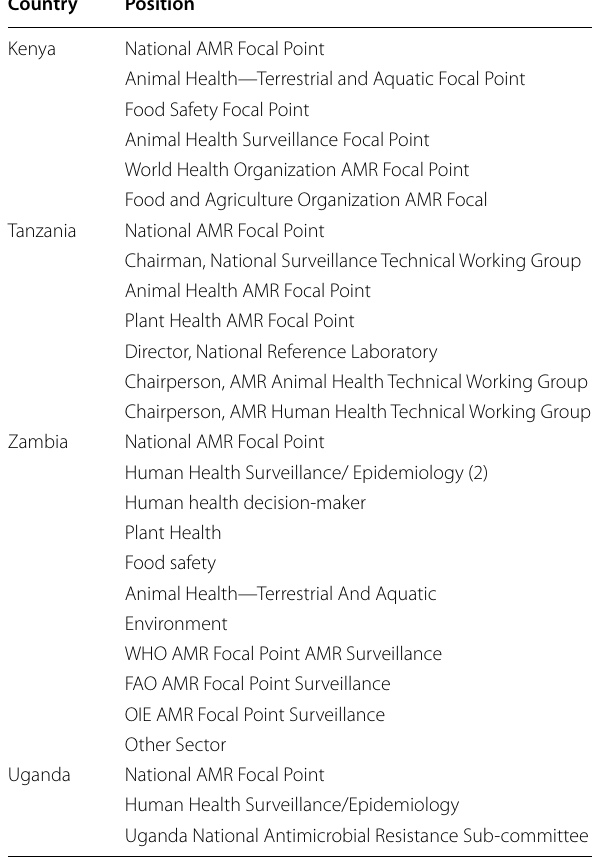
Table 1 Key stakeholders consulted by country and